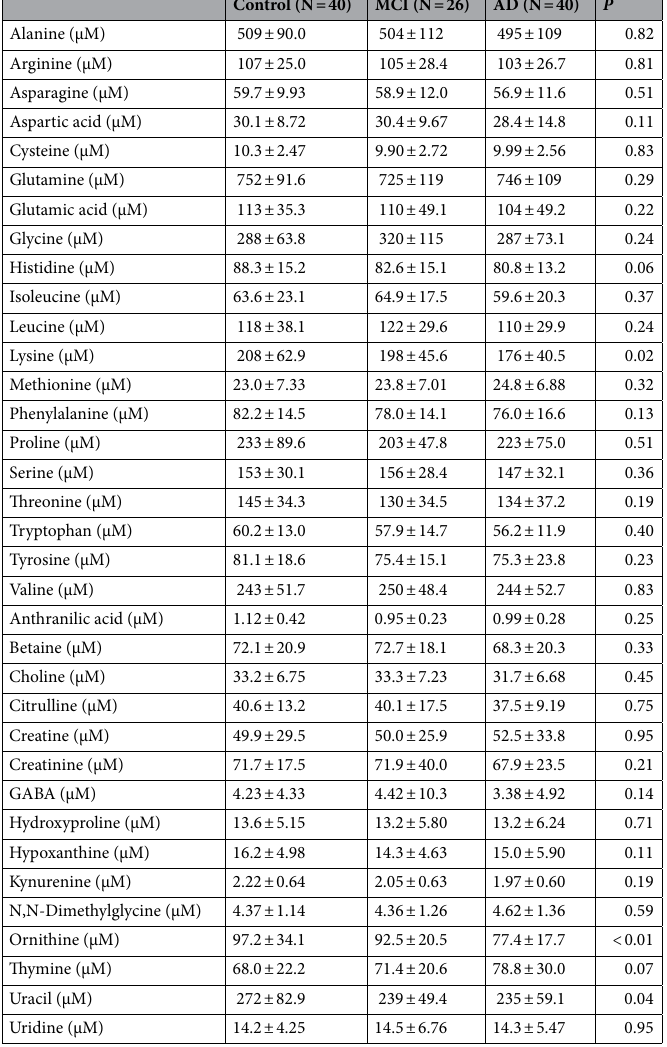
Table 3. Mean values of plasma amino acids.